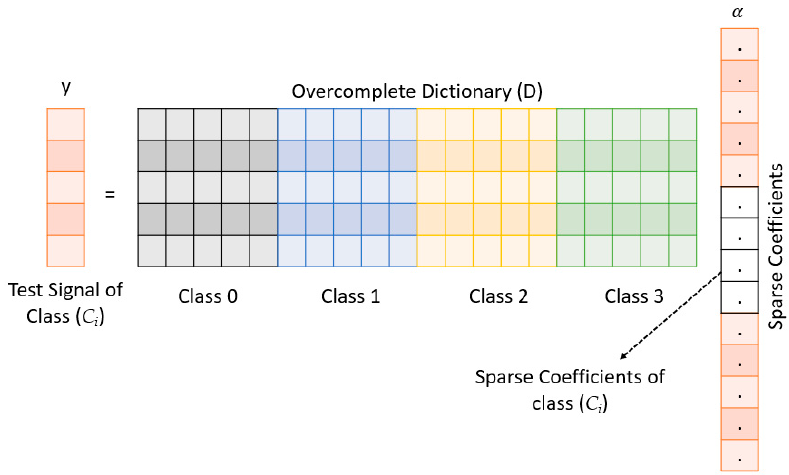
Figure 5. Sparse representation of the signal in compressive sensing.